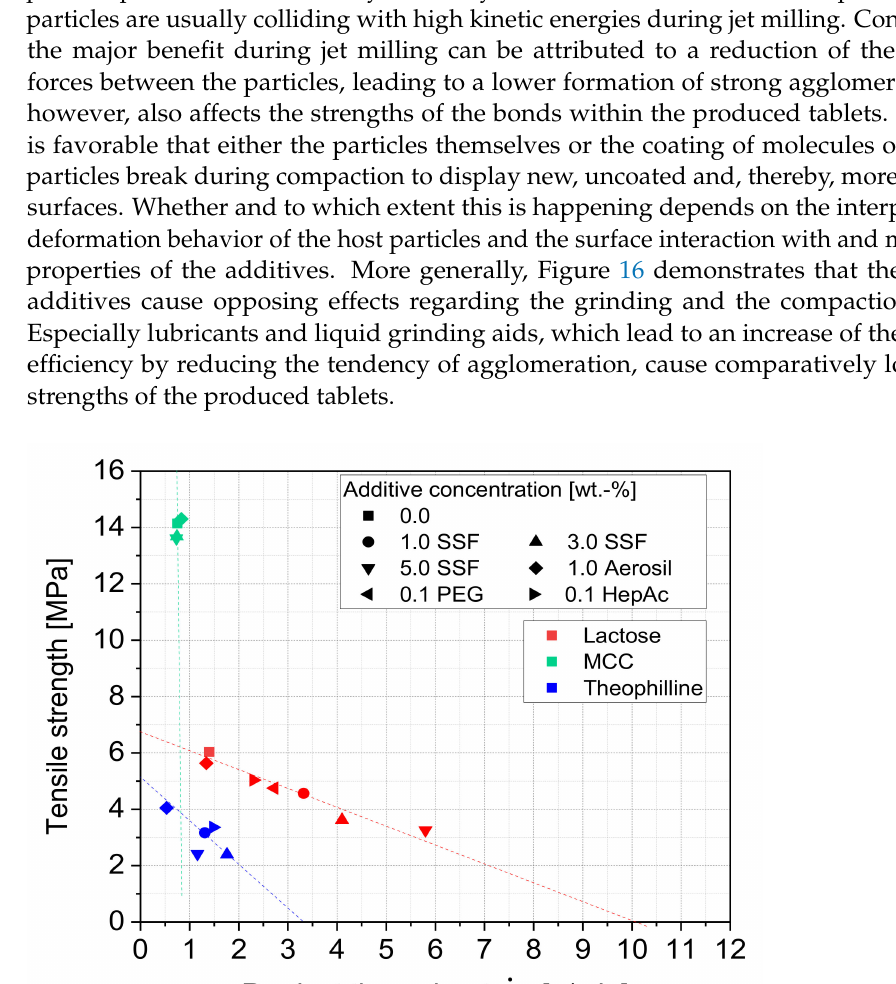
Figure 16. Correlation between the product throughput, strength of the ground and compacted powder samples (compaction stress = 400 MPa). Dashed lines act as a guide to the